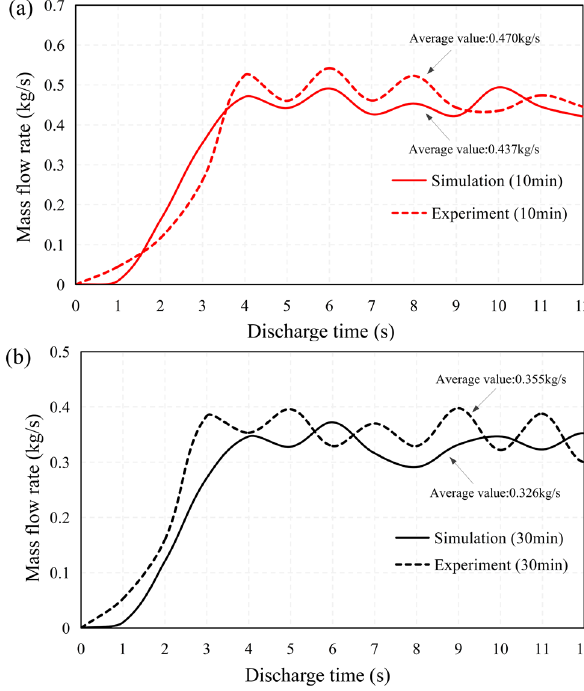
Figure 17: In fl uence of concrete fl ow characteristics on mass fl ow rate and driving power ( batch time: 5 – 25 min, screw pitch: 40 mm, fl ight diameter: 60 mm, core diameter: 24 mm, rotate speed 30 rpm ) .